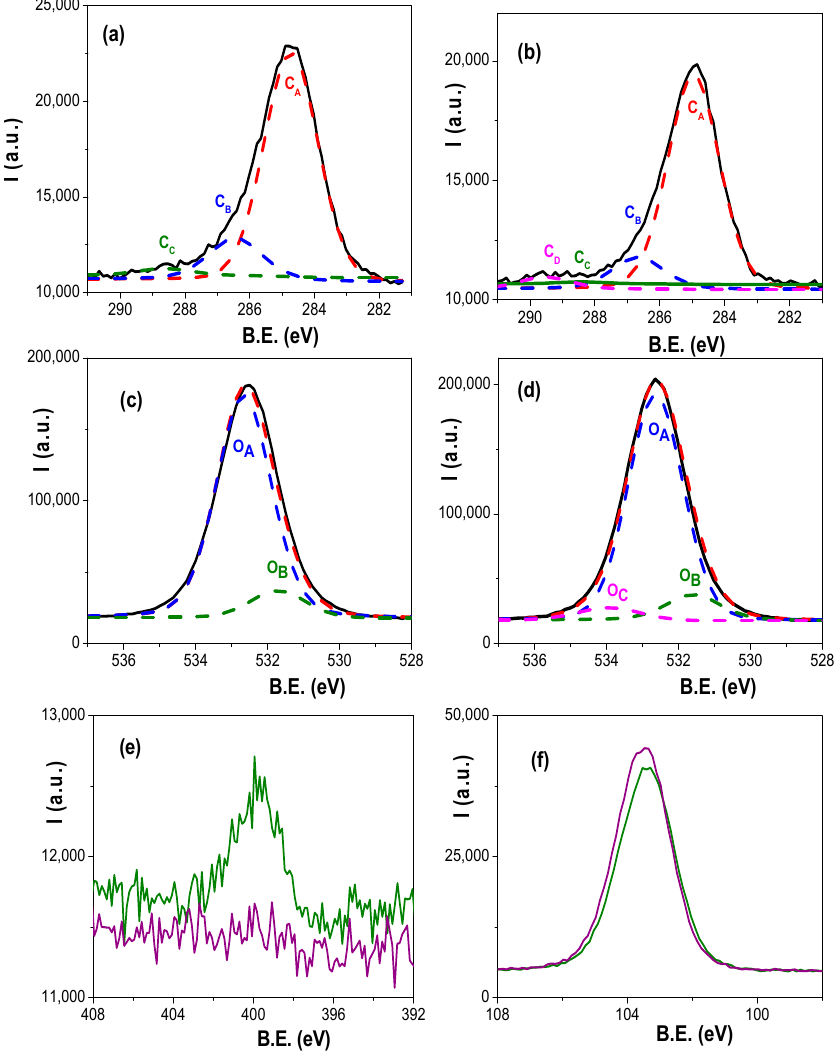
Figure 5. Carbon core level spectra (black solid line) and its deconvolution for: ( a ) Ox+SiO 2 /APTES: C A , dashed red line; C B , dashed blue line; C c , dashed green line; ( b ) Ox+SiO 2 /APTES/O 3 : C A , dashed red line; C B , dashed blue line; C c , dashed green line; C D , dashed magenta line. Oxygen core level spectra (black solid line) and its deconvolution for: ( c ) Ox+SiO 2 /APTES sample: O A , dashed blue line; O B , dashed green line; ( d ) Ox+SiO 2 /APTES/O 3 sample: O A , dashed blue line; O B , dashed green line; O c , dashed magenta line. Experimental values: red solid line; fitted values: dashed red line. ( e ) Nitrogen and ( f ) Silicon core level spectra for Ox+SiO 2 /APTES (green solid line) and Ox+SiO 2 /APTES/O 3 (purple solid line) samples.